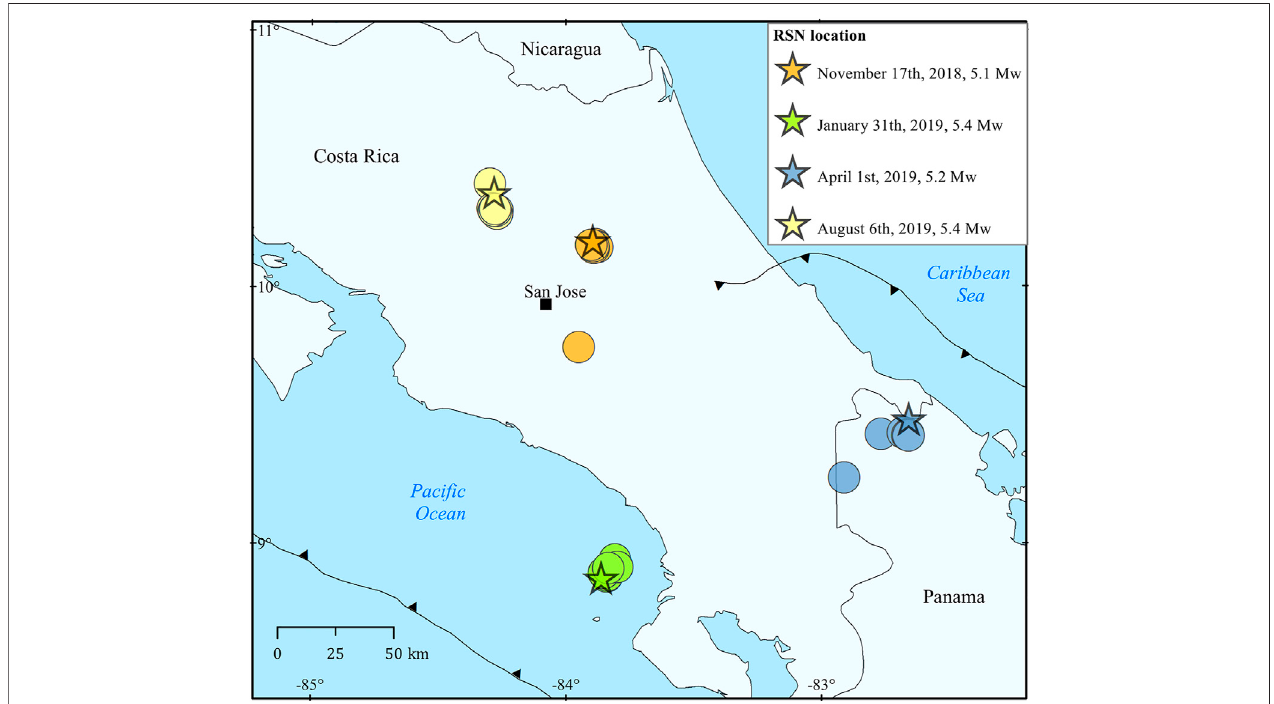
FIGURE 7 | Solutions for four events selected in different regions of Costa Rica ( Table 3 ). The stars represent the RSN locations, and the circles represent the VS solutions. The colors correspond to the date of the earthquake, as shown in the inset.